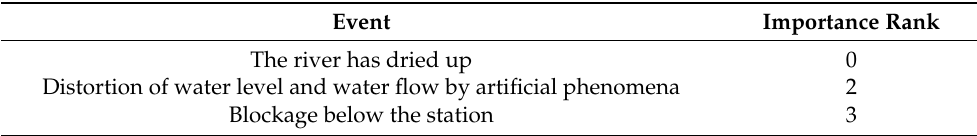
Table 4. Some events and importance ranks for them.